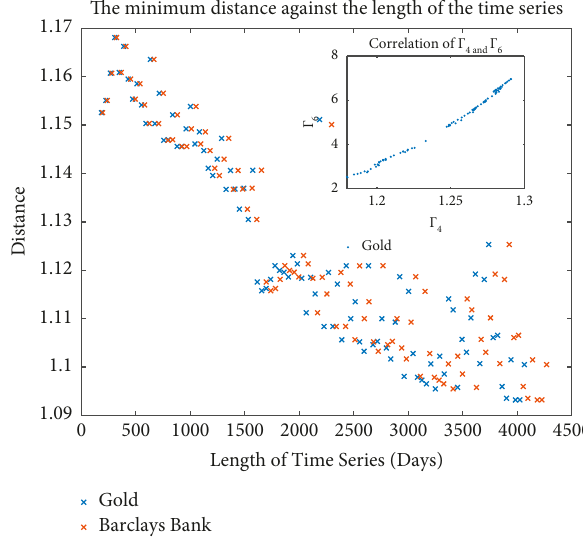
Figure 10: The minimum distance of two time series, Barclays Bank (red) and Gold ETFs (blue) between 2000 and 2018, when we truncate the time series into different lengths, is shown for the cost function (27). An insert of this plot highlights the correlation between Γ and Γ for Gold ETFs, which corresponds to a cor- 4 6 relation coefficient, ρ � 0 .